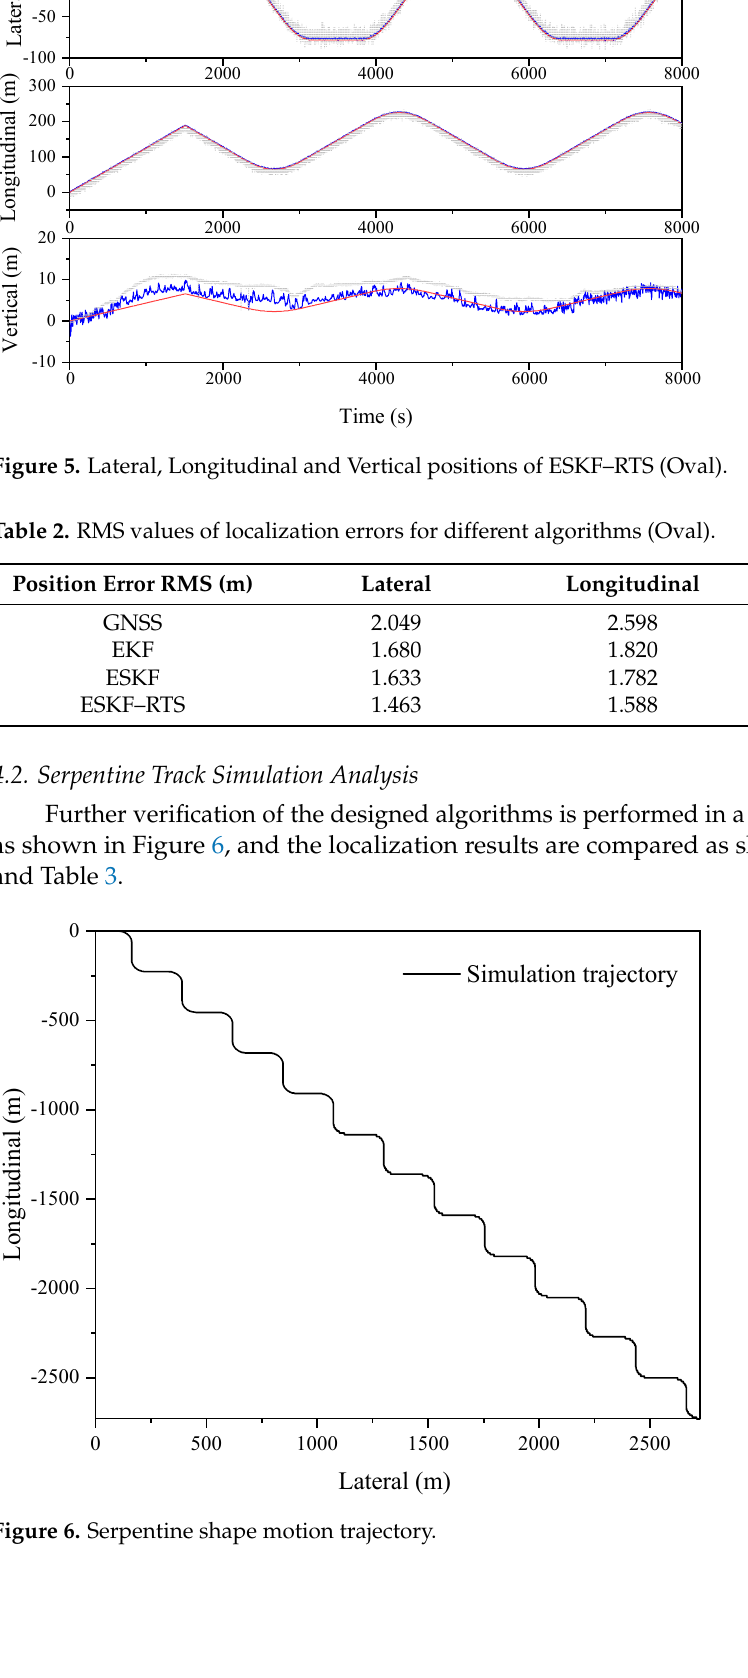
Figure 4. Lateral, Longitudinal and Vertical positions of ESKF (Oval).